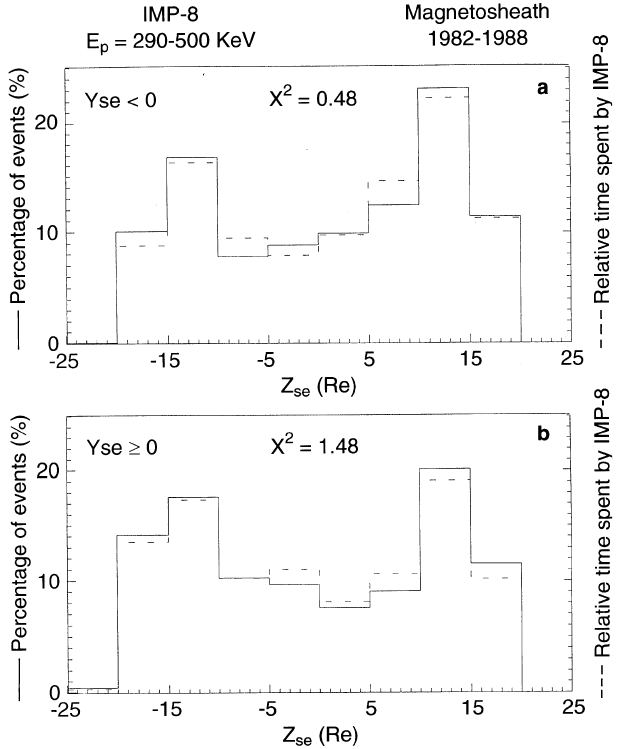
Fig. 7a,b. The percentage of energetic ion events ( solid line ) and of the relative time spent by the spacecraft ( dashed line ) as a function of the Z sc coordinate for the a dawn and b